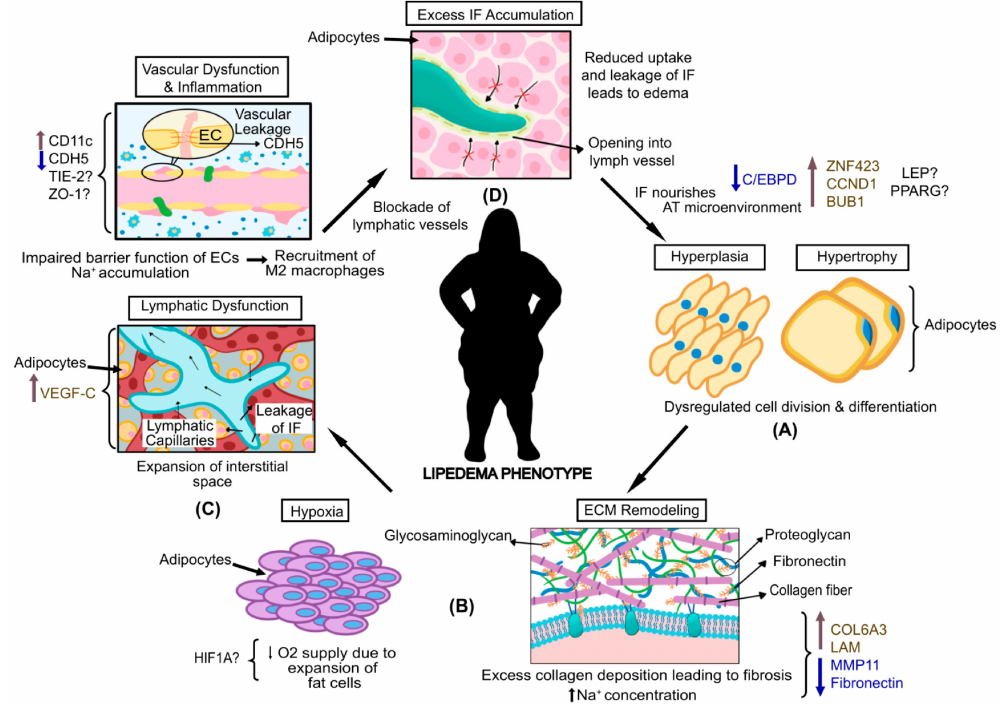
Figure 2. The cycle of events underpinning the lipedema phenotype. ( A ) Increased expression of genes associated with mitotic clonal expansion (MCE) and cell proliferation leads to hyperplasia. Although increased accumulation of lipids within fat cells leading to hypertrophy has been confirmed in lipedema, the expression of markers associated with such a finding is still under debate. ( B ) Due to the overgrowth of fat cells, there is a reduced oxygen supply, and extracellular matrix (ECM) remodeling is observed. ECM remodeling includes sodium (Na + ) concentration, collagen deposition, and disturbances in the glycocalyx (including proteoglycans and glycosaminoglycan), leading to microangiopathy and fibrosis. ( C ) Endothelial permeability and paracellular leakage are increased due to the loosening of the tight junctions between endothelial cells (ECs), further deteriorating vascular impairment and causing inflammation. In addition, the ability of the lymphatic capillaries to take up interstitial fluid (IF) is diminished, causing leakage of IF, promoting lymphatic dysfunction and expansion of interstitial space. ( D ) Pathogenic changes both at the vascular and lymphatic levels contribute to the accumulation of IF, which leads to the deposition of fluid. In addition, the excess IF surrounding the fat cells acts as a source of nutrients, further contributing to the pathological expan- sion of the fat cells, eventually causing the remodeling of SAT and lipedema phenotype cyclically. Blue: Decreased expression of these genes observed in lipedema; Brown: Increased expression of these genes observed in lipedema; Black: Contradictory findings have been reported for these